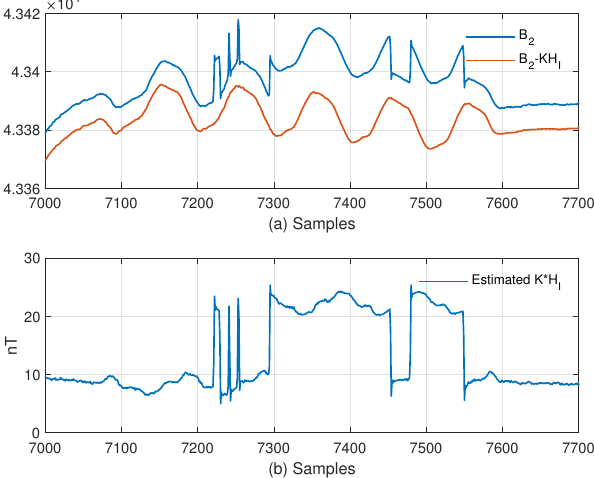
Figure 8. Magnetic interference of fluxgate during maneuvering. ( a ) Compensation effect of fluxgate. ( b ) Estimated magnetic interference of OBE at